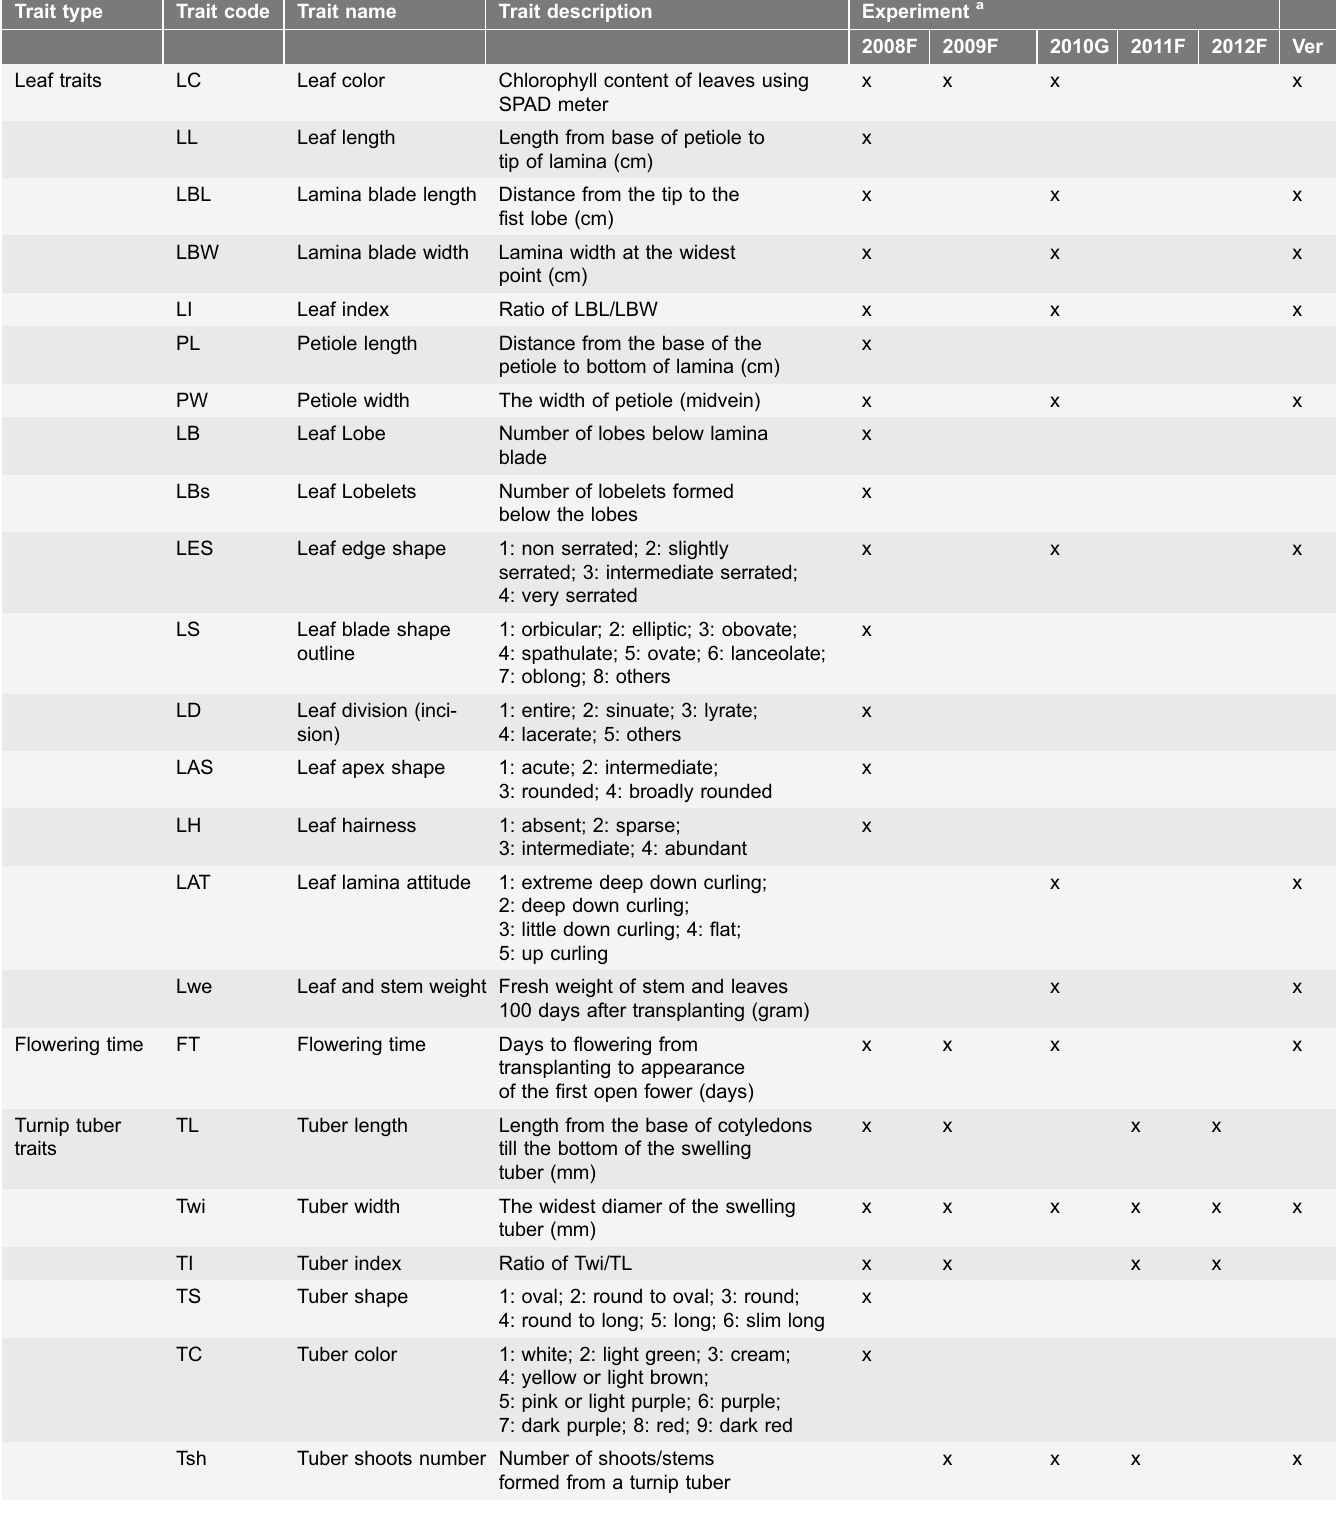
Table 2. List of evaluated phenotypic traits in five experiments. Trait